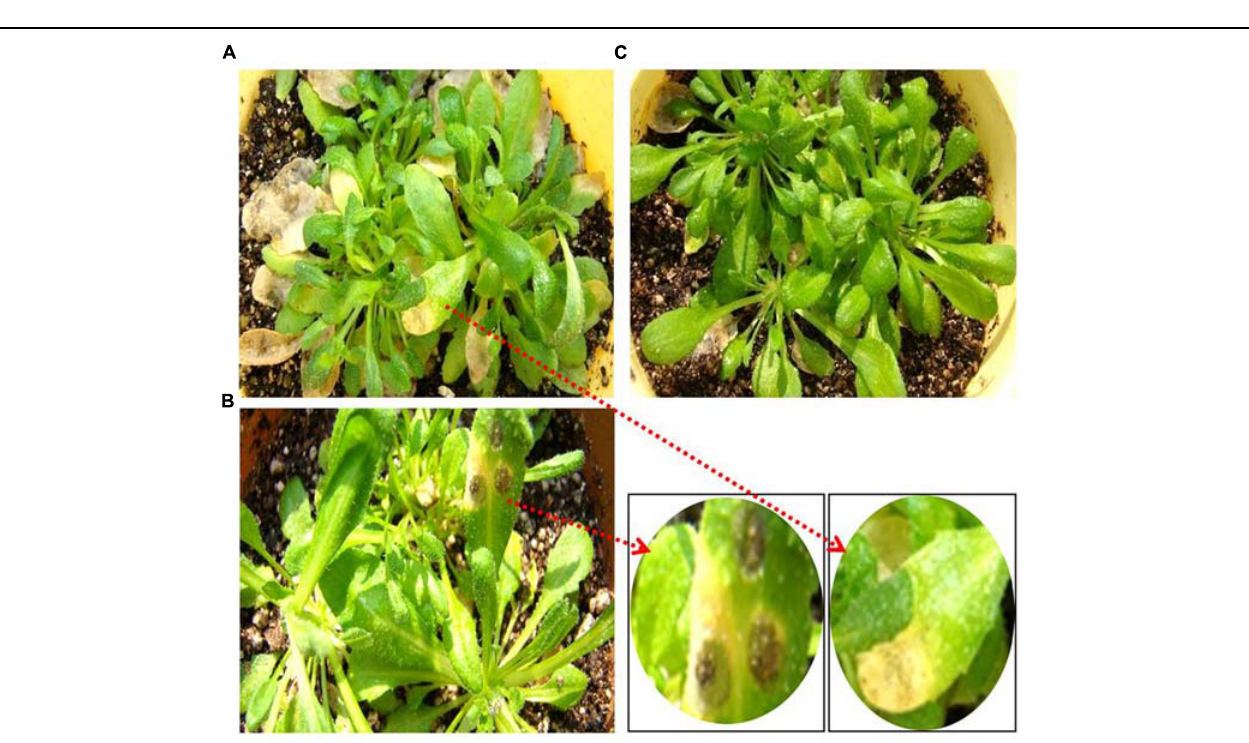
FIGURE 3 | Phenotypic response of Arabidopsis plant inoculated with M. oryzae isolate Mo-ei-11. Three days after (A) spray inoculation and (B) spot inoculation with M. oryzae ; (C) 3 days after mock inoculation with 0.2%